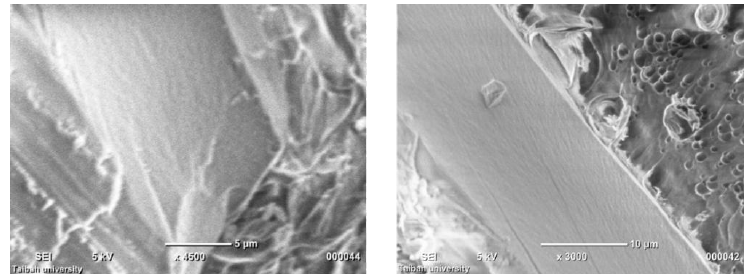
Figure 5. SEM of polynorbornene pendent spiropyran 9 . (After plasma treatment for 10 min).